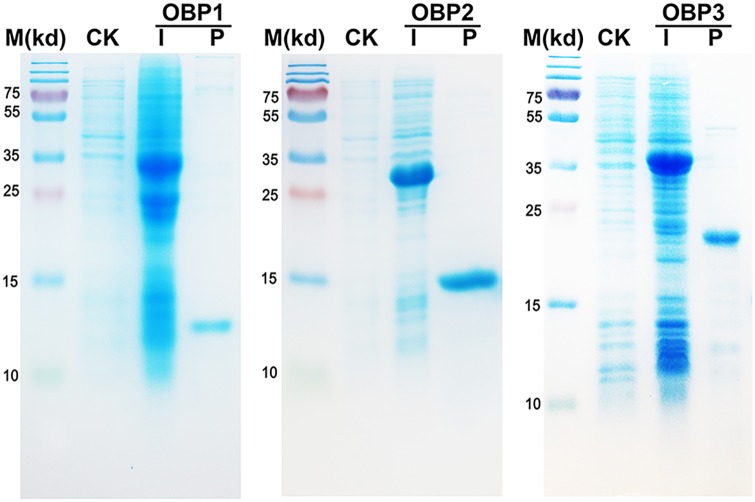
SDS-PAGE analyses showing the expression and purification of the recombinant PameOBPs.M: molecular markers; CK and I: bacterial cells before and after induction by IPTG, respectively; P: purified protein after cleavage by thrombin.